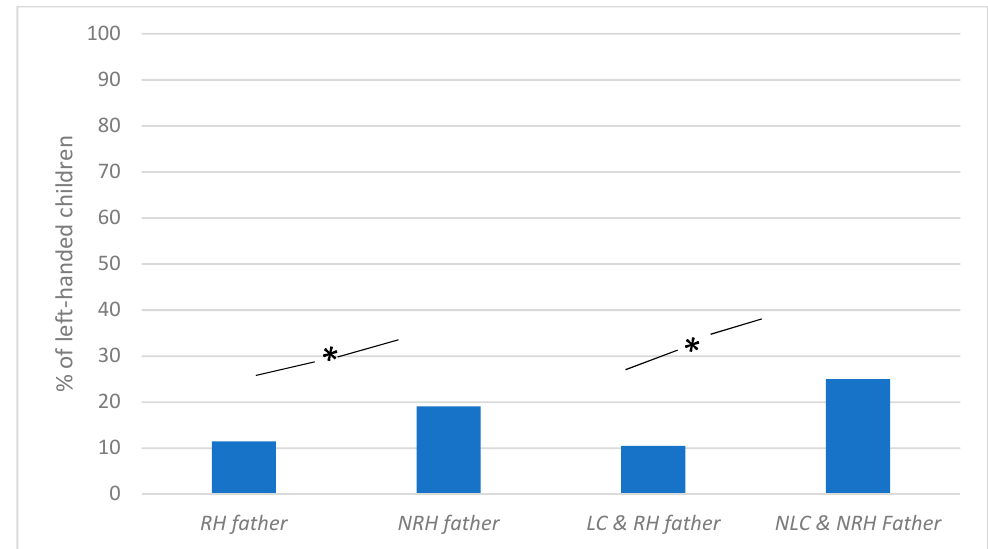
Figure 5. Percentage of left-handed children as a function of father’s handedness (RH = right- handed; NRH = non-right-handed) and father’s handedness and side of position combined (LC = left cephalic; NLC = non-left-cephalic). * = significant difference ( p < 0.05). of a right-handed father (10.5%) than among non-left-cephalic children of a non-right- handed father (25%), X 2 (1) = 6.7, p = 0.009) (see Figure 5).